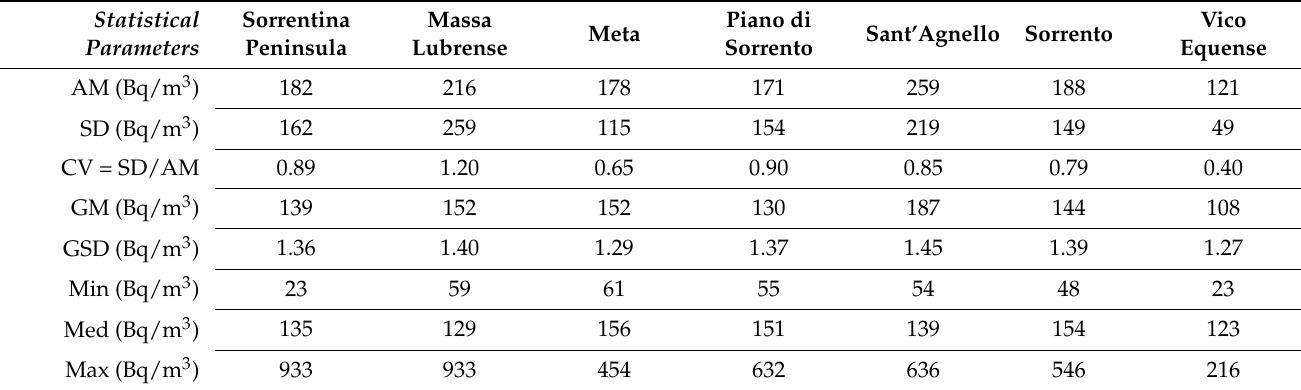
Table 2. Statistical parameters both for the total measurements on the Sorrentina peninsula and for each municipality after data normalization.